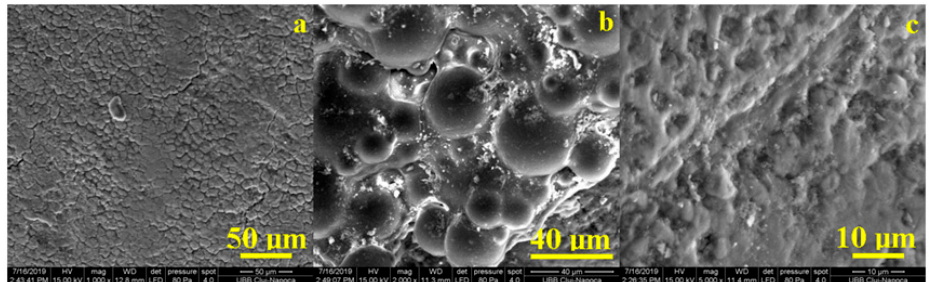
Figure 8. SEM aspect of stained enamel: ( a ) small magnification, ( b ) medium magnification, and ( c ) high magnification. Coatings 2020 , 10 , x FOR PEER REVIEW